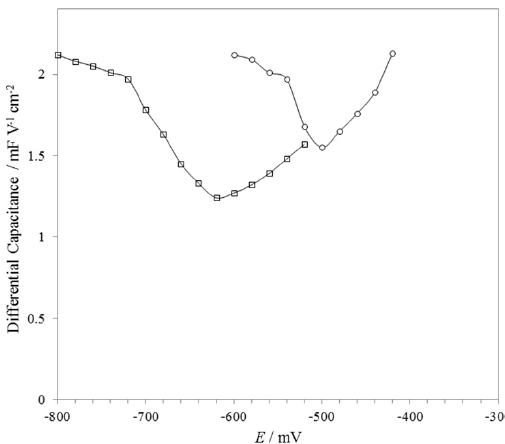
Figure 6. The plot of differential capacitance vs. applied electrode potential in 1 M HCl solution (o) and 1 M HCl containing 200 mg/L of the inhibitor solution (□).